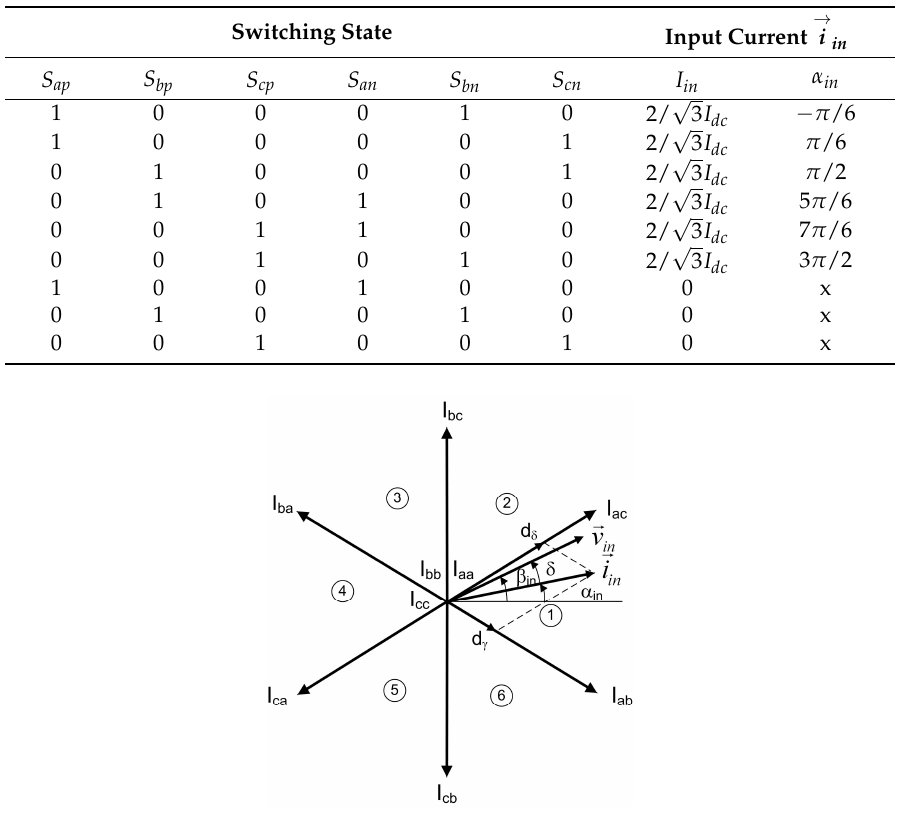
Figure 6. The space vector diagram of rectifier stage.